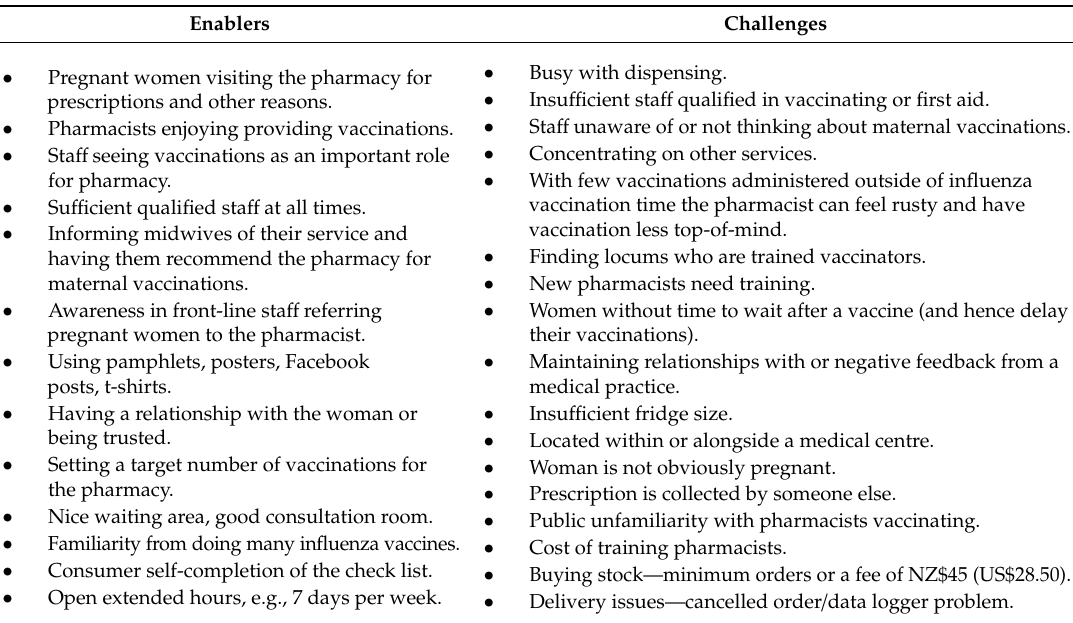
Table 3. Enablers and challenges for pharmacy in providing vaccinations or information about vaccinations during